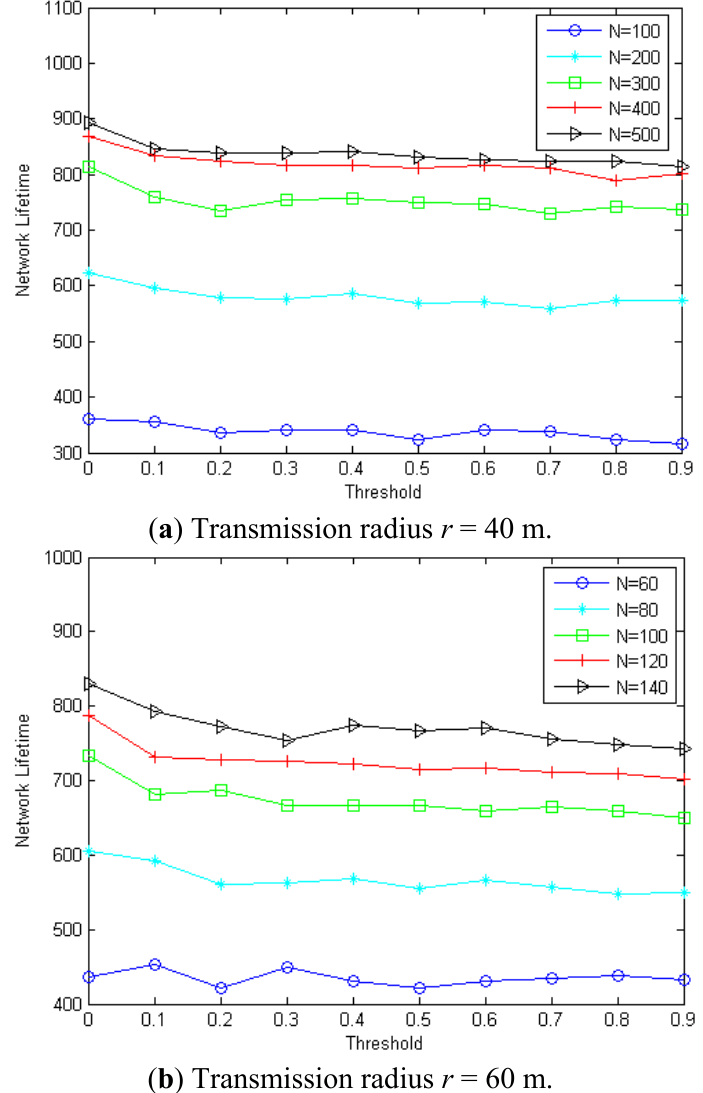
Figure 14. The impact of threshold on the performance of MEBS. ( a ) Transmission radius r = 40 m; ( b ) Transmission radius r = 60